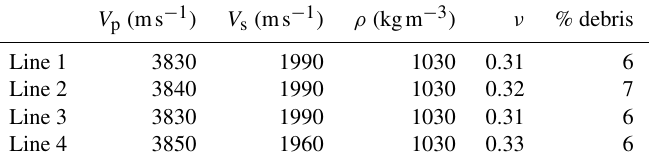
Table 3. Seismic properties estimated in the lower ice shelf.